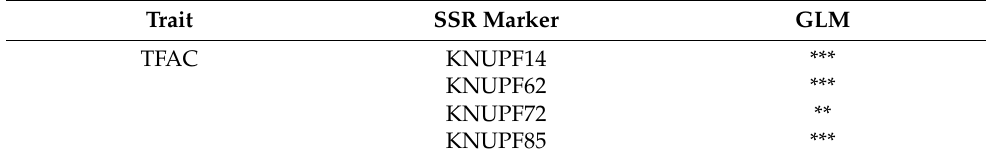
Table 4. Information on SMTA markers using the GLM method for 100 Perilla